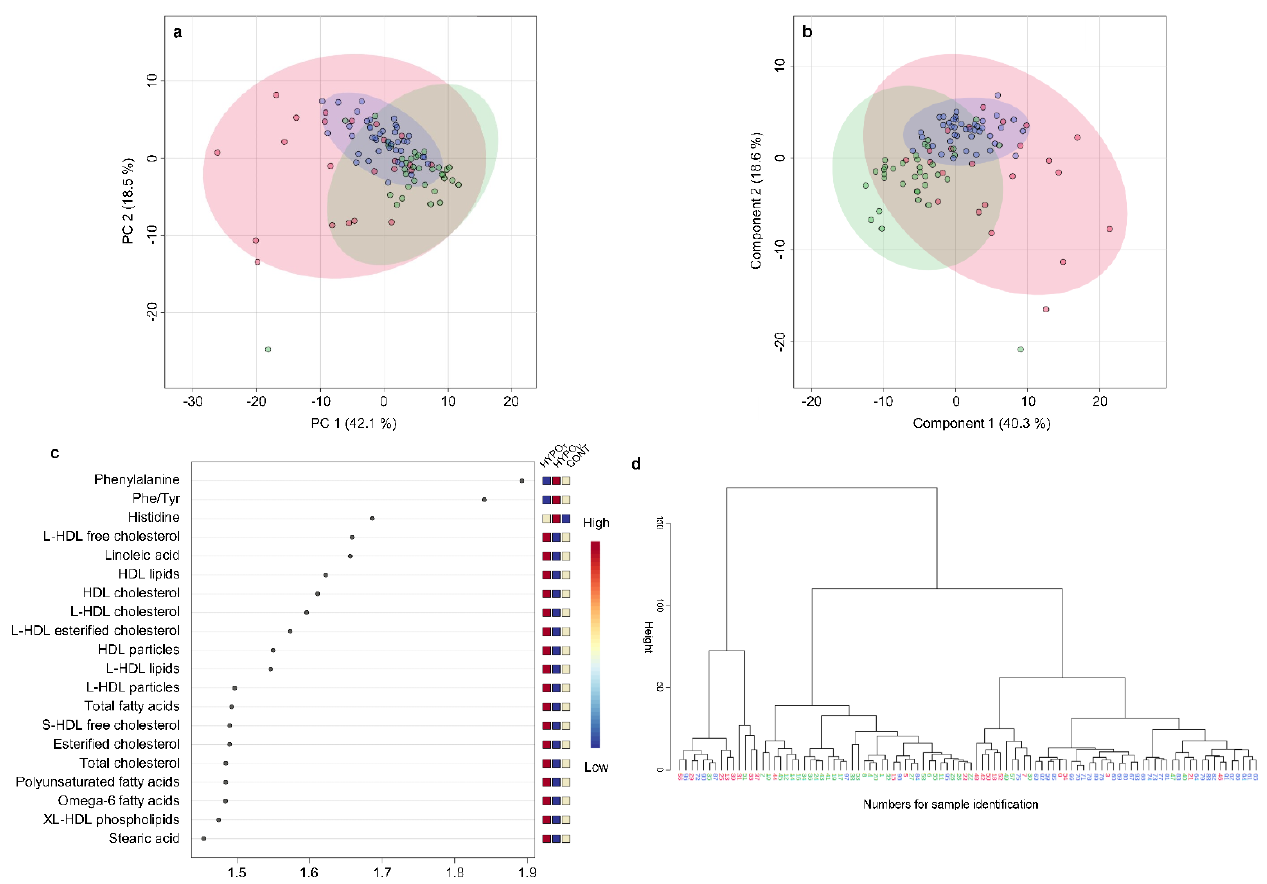
Figure 6. Metabolomic analyses of serum samples in the groups of hypoadrenocorticism untreated (HYPO U , n = 35), hyperadrenocorticism treated (HYPO T , n = 23), and the control group (CONT, n = 40). ( a ) Scores plots of principal component analysis (PCA) and ( b ) partial least squares-discriminant analysis (PLS-DA) based on metabolomics data of serum samples from dogs in HYPO U (green), HYPO T (red), and the CONT groups (blue). Shaded circles represent 95% confidence intervals, while colored dots illustrate individual samples. The axes are labeled by the first and second (principal) components with the percentages of variance of the data explained by that component in parenthe- ses. ( c ) Variable importance in projection (VIP) scores of component 1 of the PLS-DA identifies the top 20 discriminating parameters in descending order of importance. The colored legend on the right indicates the relative abundance of variables, with red and blue indicating high and low val- ues, respectively, while beige illustrates neutral values. ( d ) Dendrogram of hierarchical cluster anal- ysis of serum metabolomic results from canine samples in either HYPO U (green), HYPO T (red), or the CONT group (blue). Each number on the x-axis reflects one serum sample. The y-axis shows the similarity levels expressed as Euclidean distances. Horizontal and vertical lines depict clustering of samples and differences in the distances, respectively.